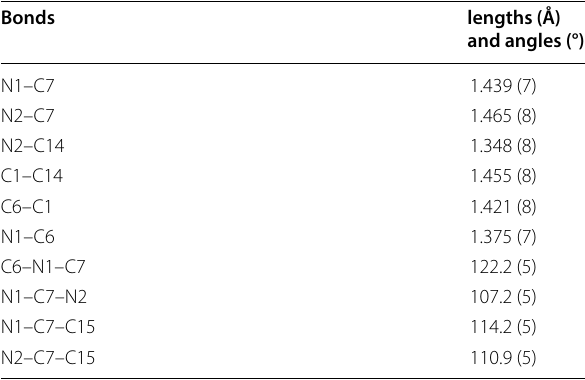
Table 3 Selected bond lengths (Å) and angles (°) Bonds lengths (Å)